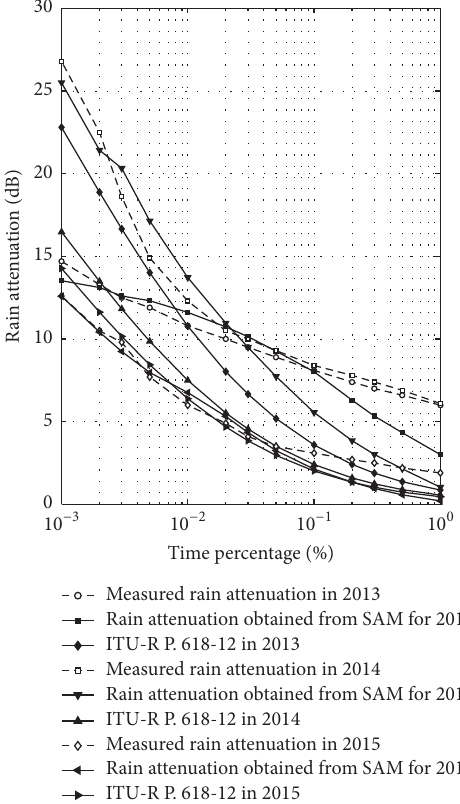
Figure 6: Comparison between empirical measured data and ITU- R P. 618-12 at 12.25 GHz